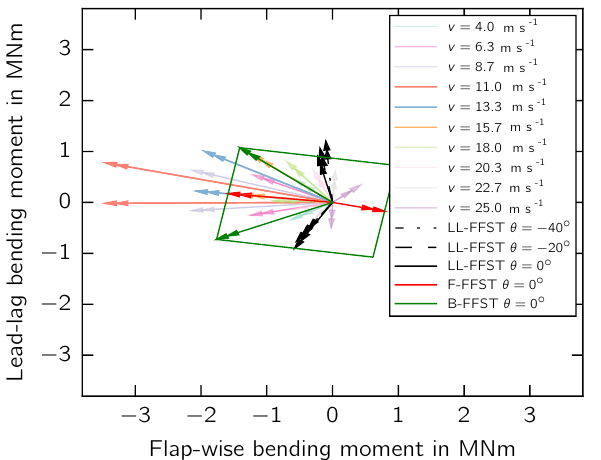
Figure 6. Moment vectors of lead–lag loading at different wind speed bins and in a lead–lag fatigue full-scale blade test (LL-FFST) at different pitch angles at 70% blade length. A flapwise FFST (F- FFST) and the bounding box of possible bi-axial FFST scenarios (B-FFST) are